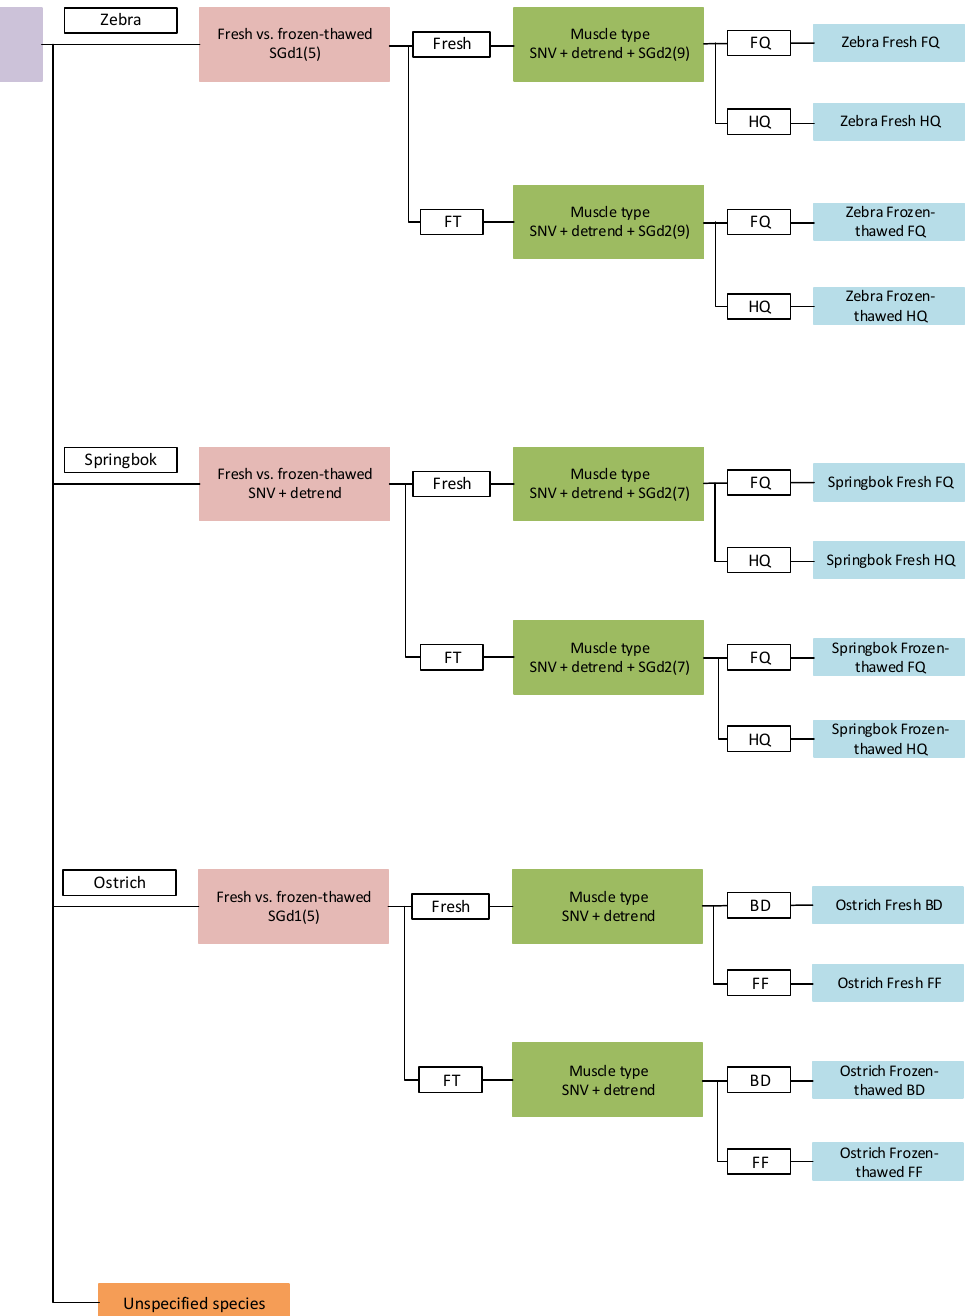
Figure 5. Schematic of the hierarchical model exhibiting the PLS-DA models and pre-processing used for differentiating between zebra, springbok, and ostrich, fresh and previously frozen (FT) meat, and the muscle types (forequarters (FQ), hindquarters (HQ), gastrocnemius (BD), and iliofibularis (FF)).